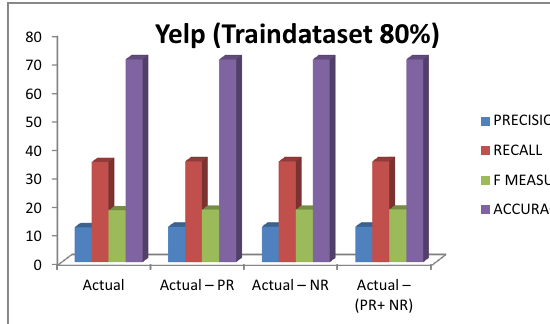
Figure 7: Plot for Yelp 80% train dataset.